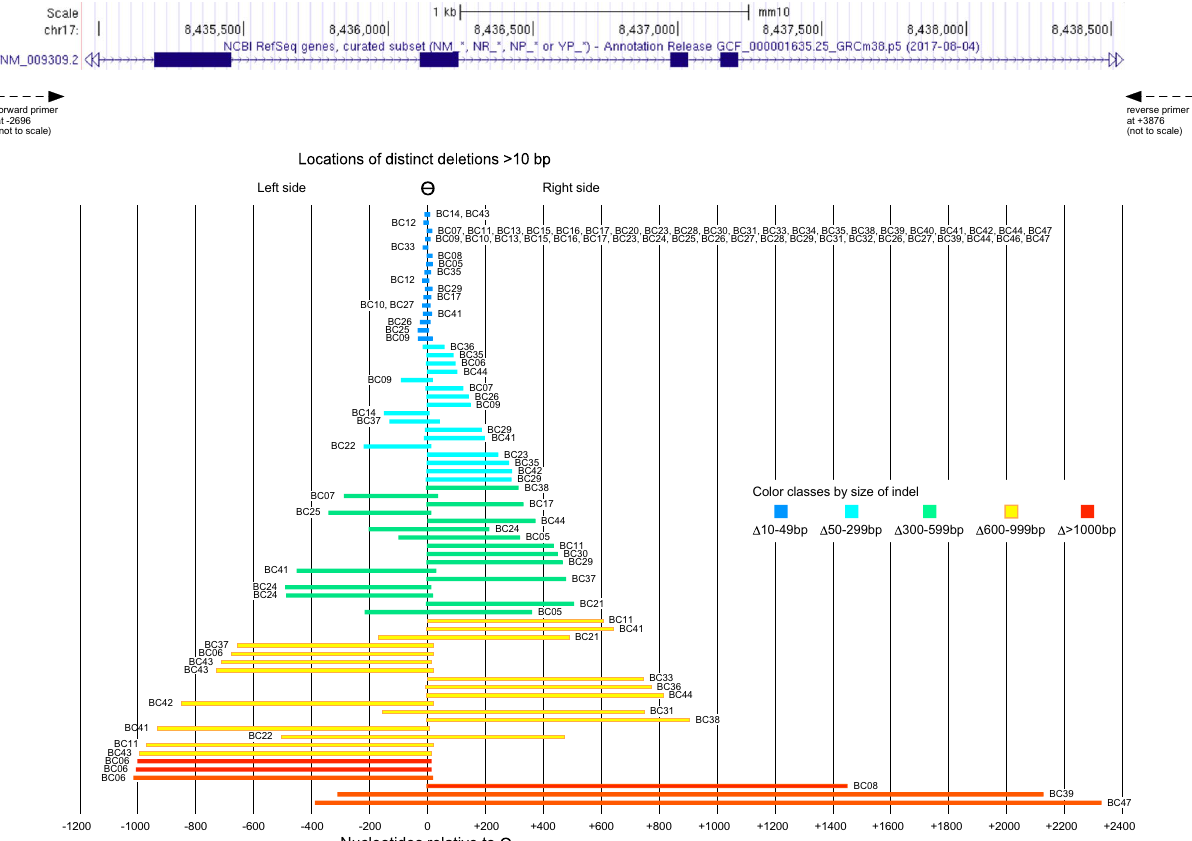
Figure 7. Locations of individual larger deletions in the T locus of CRISPants. Each deletion of greater than 10 bp is shown as a single line, ordered by overall size from the bottom up. All deletions end at, originate at or span across ϴ . Of note, a large fraction of the deletions are asymmetric relative to the cut site. Deletions are colored according to size, and the individual samples in which they appear are listed next to the respective